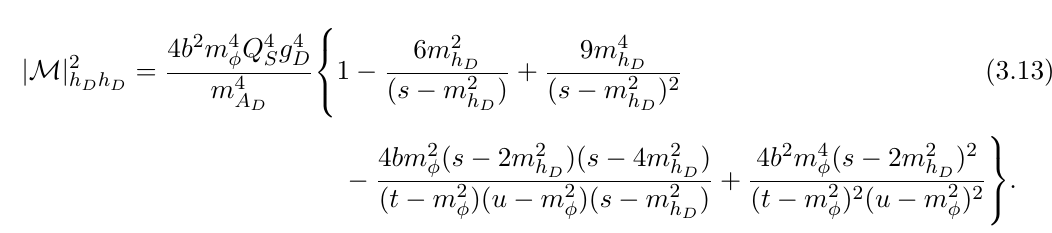
∗ φ → h D h D amplitude at tree level.